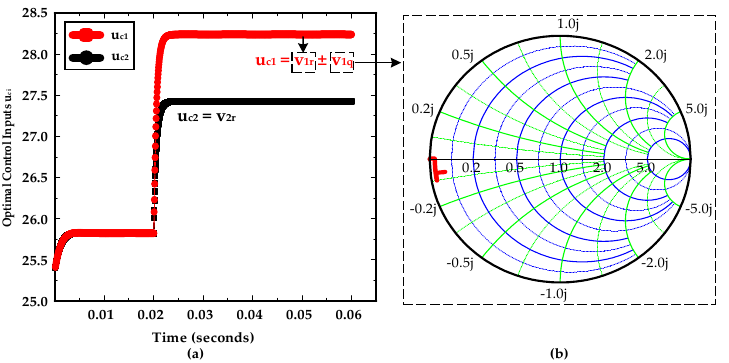
Figure 13. An optimal control inputs ( u ci ) to lab-scaled distributed generation units ( a ) Variation of u ci ( u c1 , u c2 ) under disturbance load at 0.02 s. ( b ) An imaginary part ( v 1q ) of u c1 curve, in red, on smith chart.